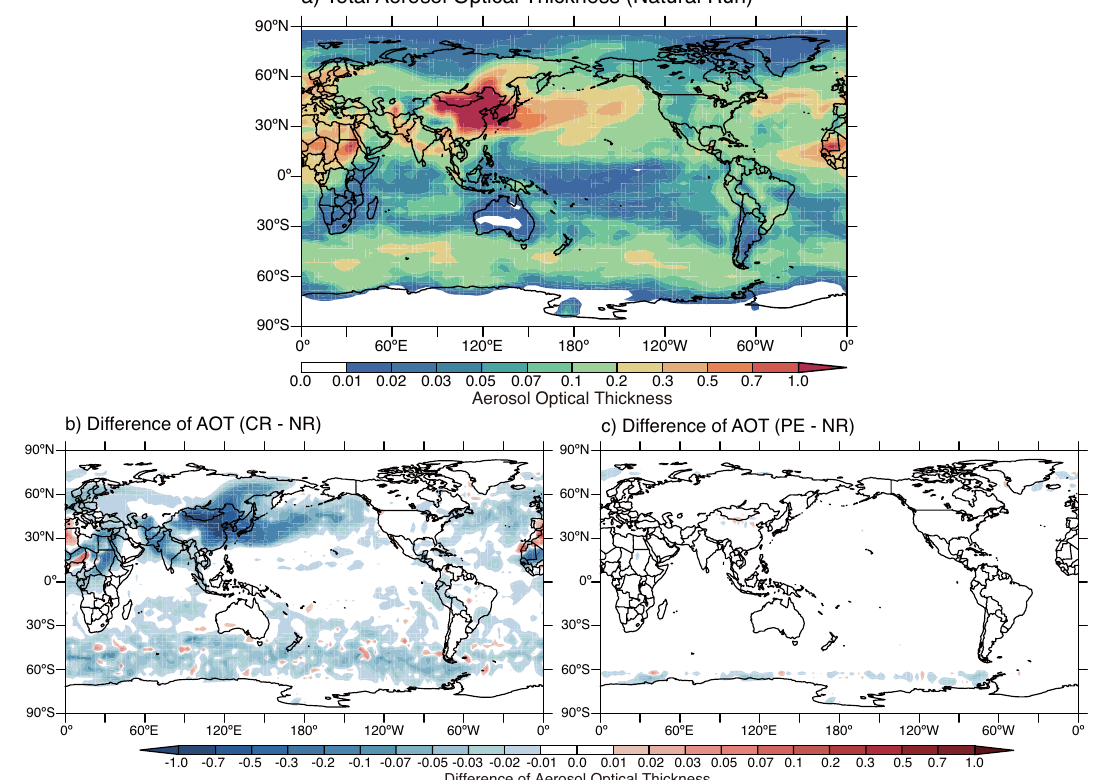
Fig. 6. Spatial distributions of the averaged AOT and its deviations (CR minus NR, and AR minus NR). (a) 10day averaged total AOT from NR, (b) deviation between CR and NR, and (c) deviation between the PE and NR.